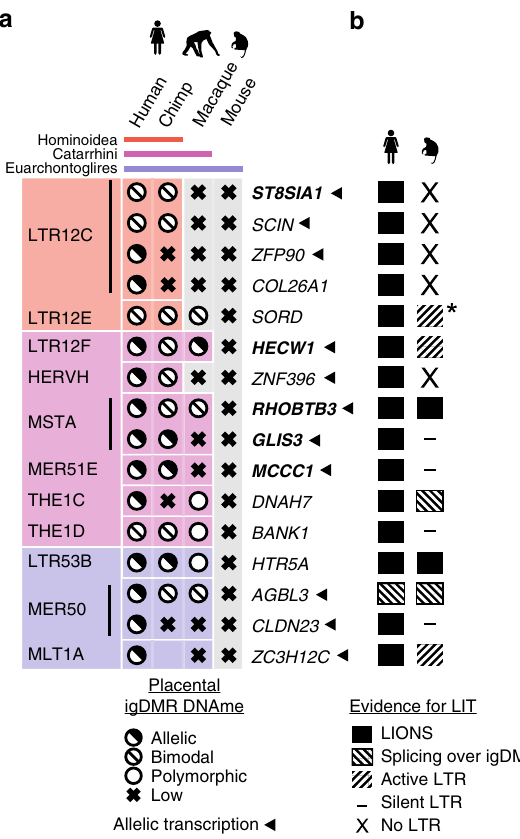
Fig. 2 Conservation of oocyte LTR-initiated transcription and gametic imprinting in primates. a Table of 16 human genes with igDMRs embedded within LITs active in oocytes and showing maternal/allelic DNAme in blastocyst and cytotrophoblast. The family of the initiating LTR is shown on the left, color-coded according to the phylogenetic distribution of the ERV family (top), as in Fig. 1a. For each species, the presence of the LTR insertion at each locus is indicated by a matching colored box and the igDMR DNAme status in human or the syntenic region in chimp, macaque and mouse placenta is shown. An empty box indicates no data. Arrows indicate genes for which evidence of allelic transcription has been published (Supplementary Data 2). Gene names in bold were analyzed in greater detail. b Conservation of LITs in human and macaque oocytes for the 16 igDMRs from panel a . Solid boxes indicate LITs discovered by LIONS, boxed hatches indicate LITs with evidence of splicing from the LTR over the igDMR, and unboxed hatches indicate evidence of transcription from the LTR. Dashes indicate LTRs from which no transcription is seen, and loci for which the relevant LTR is absent from the macaque genome are also shown (X: No LTR). Asterisk denotes an LTR12F that may initiate a LIT in macaque oocytes (Supplementary Fig. 4b). con fi guration (Supplementary Table 1). At the RHOBTB3/ Rhobtb3 locus for example, transcription in human oocytes initiates within an unmethylated primate-speci fi c MSTA element located ~25 kb upstream of the promoter CGI/igDMR, forming a chimeric transcript that splices to the downstream genic exons of RHOBTB3 (Fig. 1c). Coincident with this LIT, a large block of DNAme is deposited in oocytes over the promoter CGI and overlapping igDMR. Importantly, these regions are hypomethy- lated in human female 11-week gonadal PGCs 8 and in sperm. As imprint is maintained in the blastocyst and cytotrophoblast 26 , but is hypomethylated (<2% DNAme) in adult tissues (Fig. 1b-c and